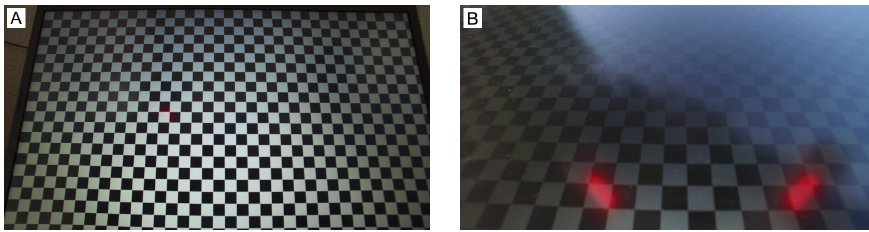
Figure 12. hlImages for intrinsic calibrations L 1 ( A ) and L 2 ( B